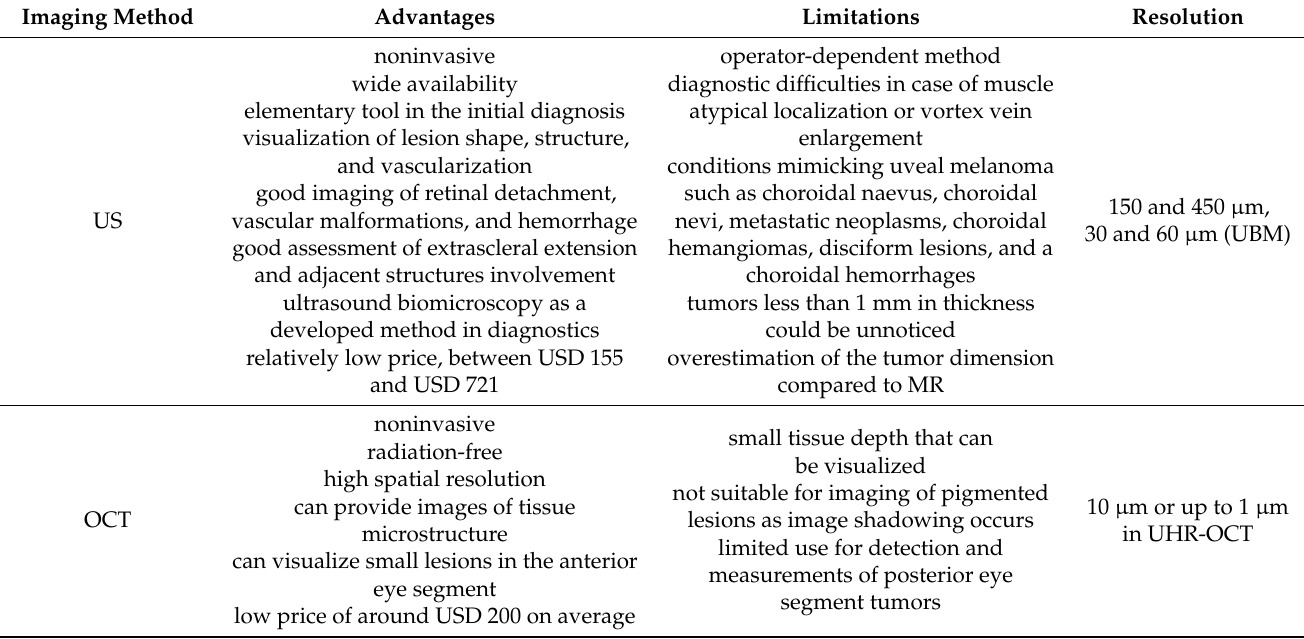
Table 1. The summary of advantages and limitations of currently available uveal melanoma imaging